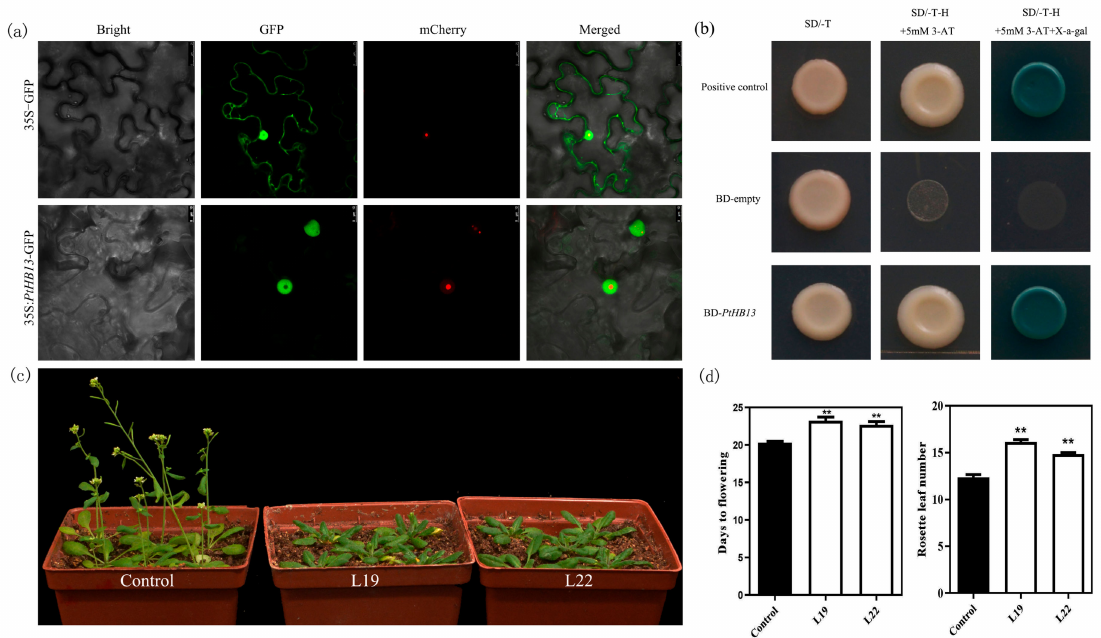
Figure 4. Functional analysis of PtHB13 in Arabidopsis . ( a ) PtHB13-GFP localization in tobacco cells; ( b ) Transcriptional activation analysis of PtHB13 . Yeast cells carrying pBD-PtHB13 vector, pGBKT7,